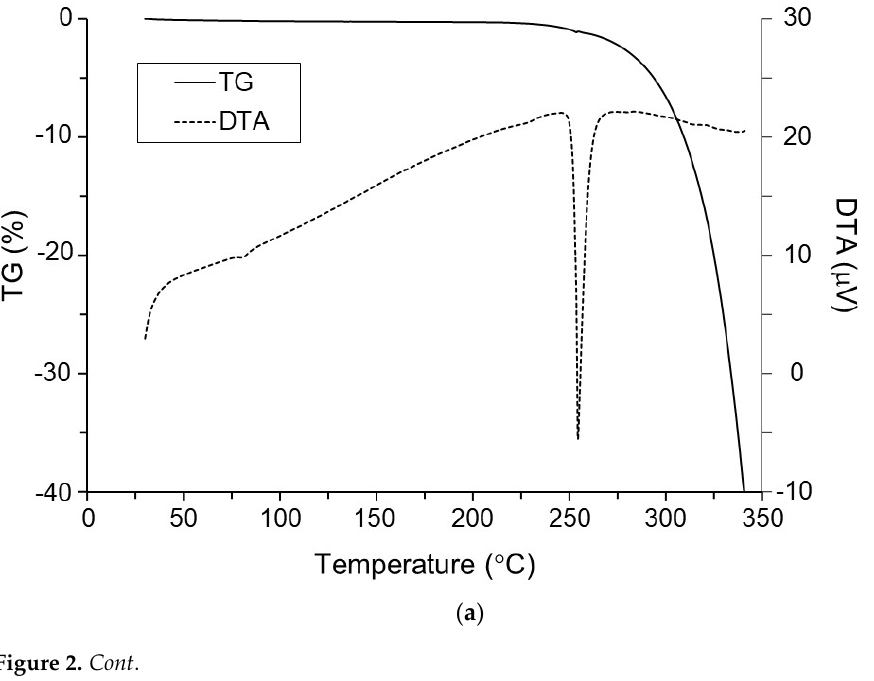
Table 1. Thermal properties obtained by TG/DTA analysis for AntiY 5 R and NaTC. Compounds Tm and Tdeg mean the melting point and thermal degradation temperatures, respectively. N.D. mean “not detected”. Results are expressed as the mean ± S.D. of three experiments.